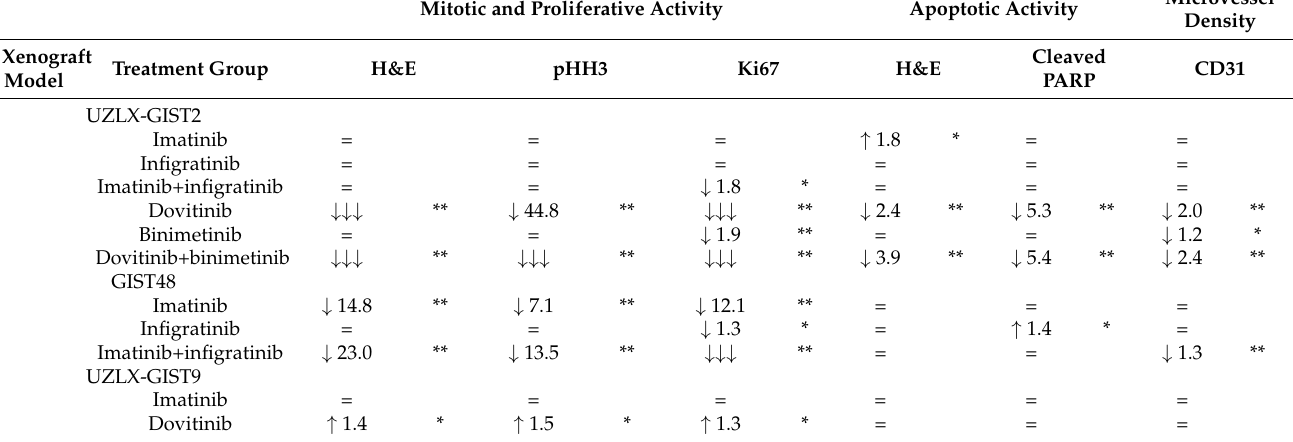
Table 3. Histological assessment of proliferative and apoptotic activity, performed on tumors collected after the treatment. Results are shown as fold changes in comparison with